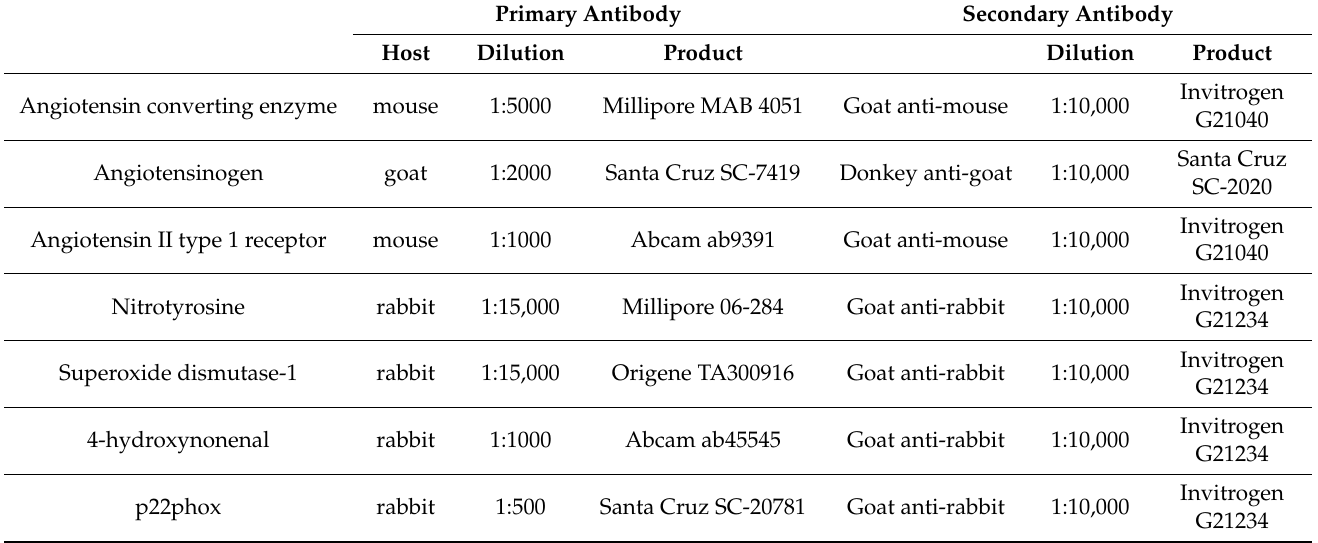
Table 1. Western blot antibodies and dilutions.